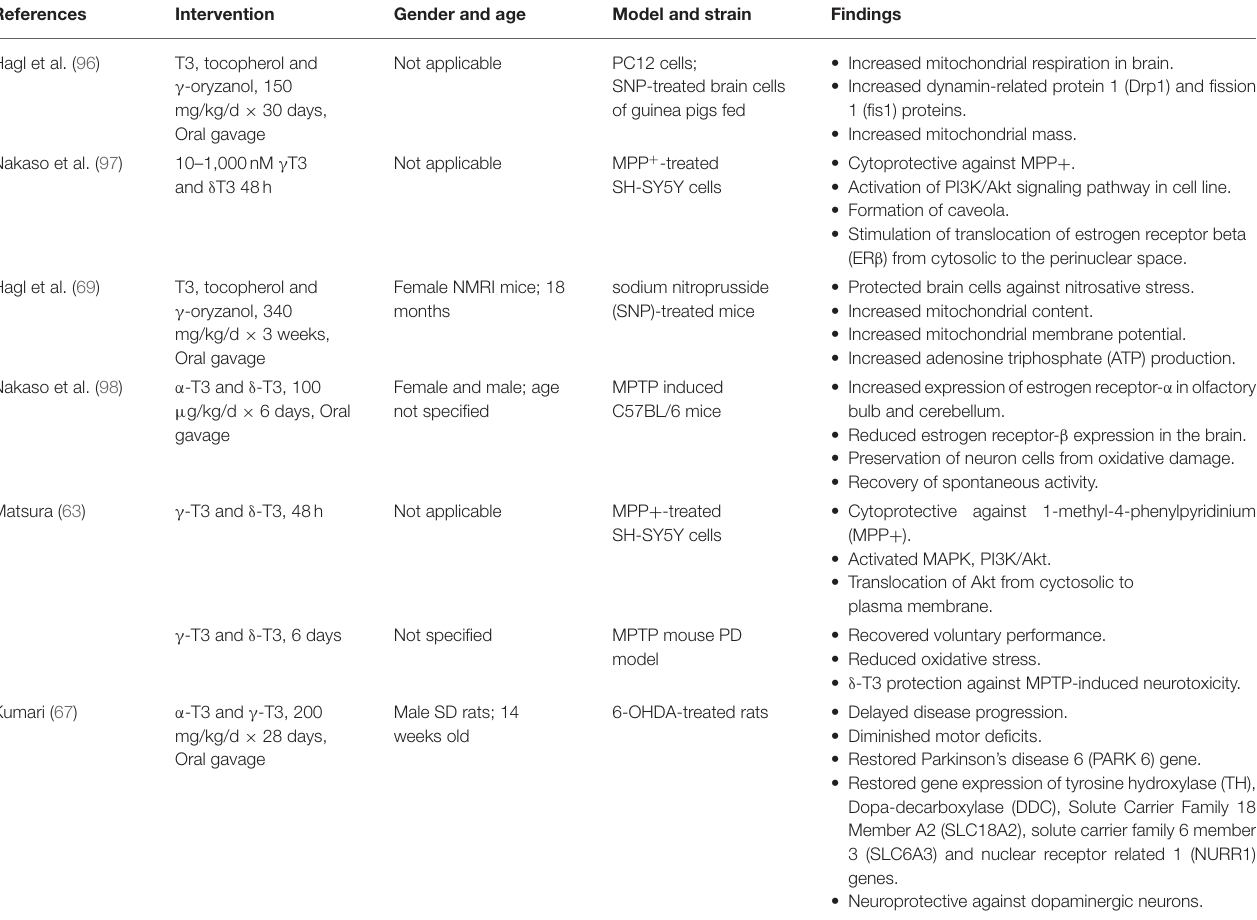
TABLE 2 | Effects T3s on Parkinson’s disease in in vitro and in vivo